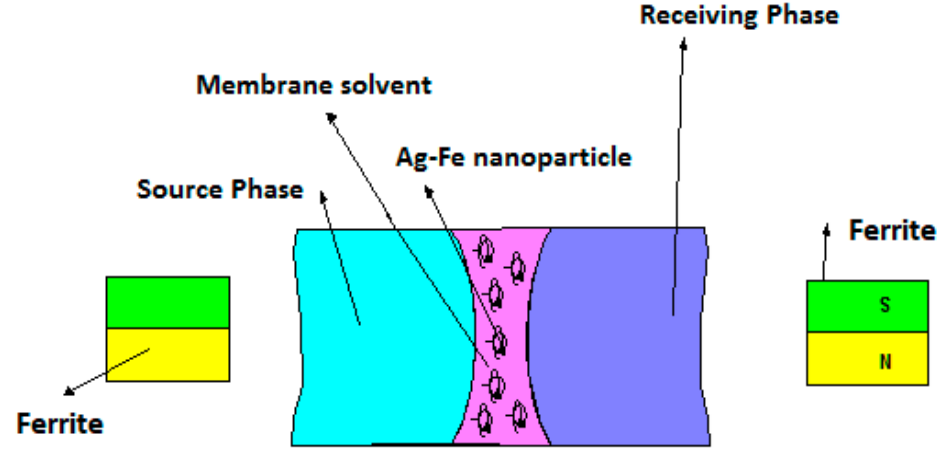
Figure 9. Schematic representation of the membrane system with magnetic iron oxide–silver nanoparticles onto the polypropylene fibers support.